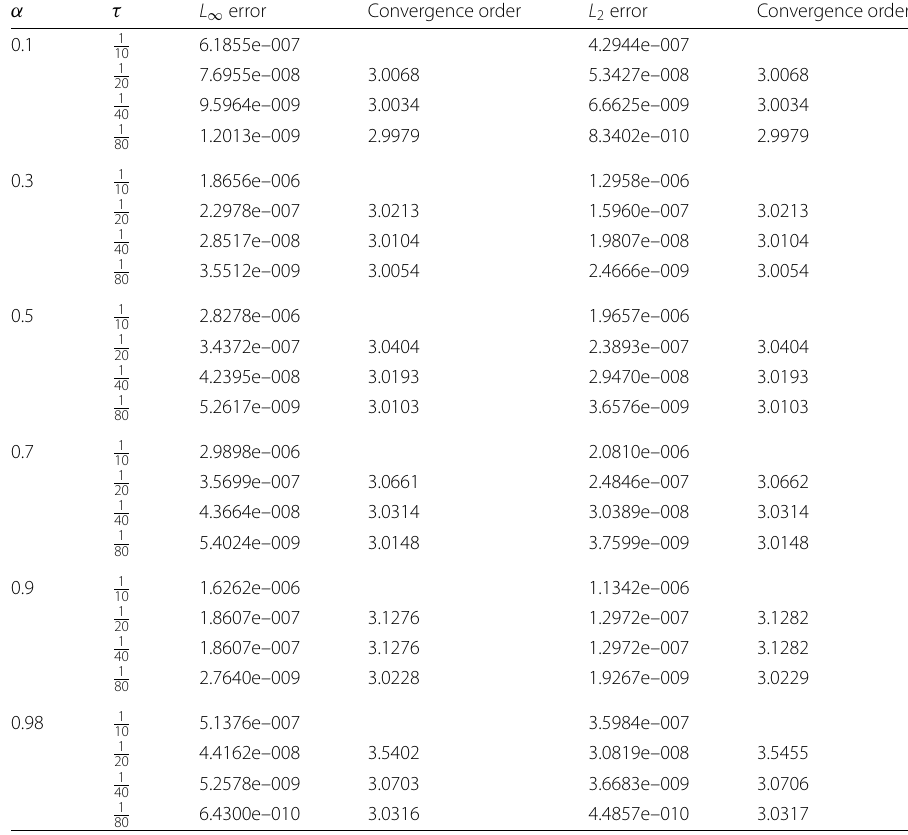
Table 1 The L ∞ , L 2 errors and temporal convergence orders with h = 1/1000 for Example 1 α τ L ∞ error Convergence order L 2 error Convergence order 0.1 1